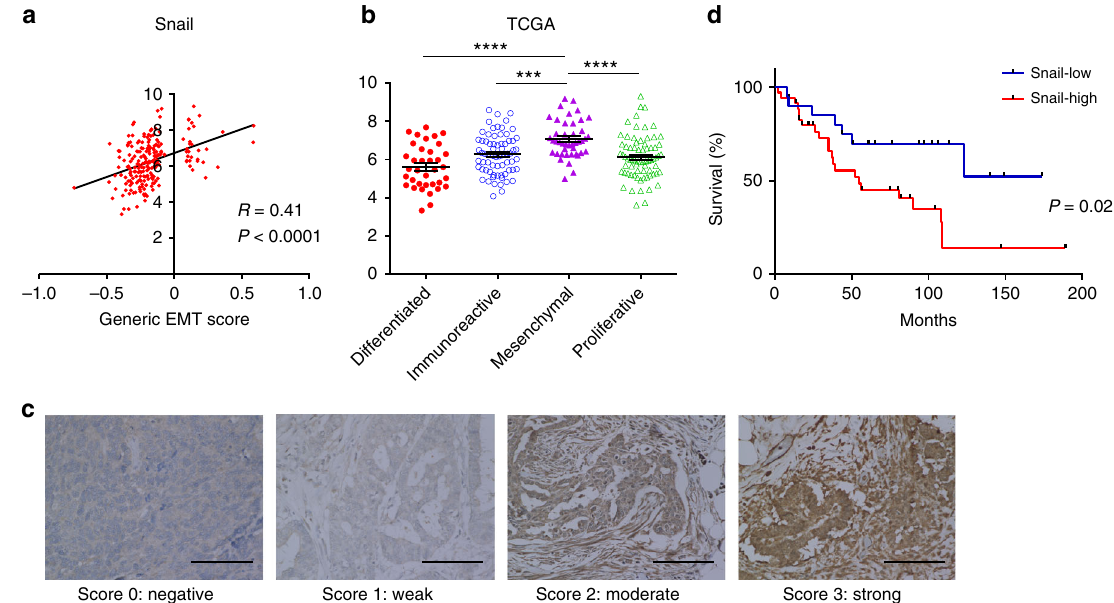
Fig. 1 Snail expression is related to epithelial-to-mesenchymal transition and poor prognosis in ovarian cancer. a Correlation between generic epithelial-to- mesenchymal transition (EMT) scores for 266 high-grade serous ovarian cancer (HGSOC) samples from TCGA dataset 1 and Snail expression. The EMT signature was acquired from a previous report by Tan et al. 3 . Generic EMT scores were calculated following the method of single-sample Gene Set Enrichment Analysis (ssGSEA). The correlation coef fi cient ( R ) and P -value were based on Pearson ’ s product-moment correlation analysis; R = 0.41 P < 0.0001. b Snail expression in HGSOC samples representing four subtypes from the TCGA datasets; *** P < 0.001 and **** P < 0.0001, mesenchymal vs. the other three subtypes based on one-way ANOVA with Tukey ’ s multiple comparisons test. Bars: mean and SEM. c Classi fi cation of HGSOC as determined by the intensity of nuclear Snail immunostaining. Cases with scores of 0/1 were assigned to the Snail-low group, whereas those with scores of 2/3 were assigned to the Snail-high group to be used in survival analysis. Scale bars, 100 μ m. d Overall survival curves for patients with HGSOC in Kyoto University Hospital ( n = 56; 48 stage III cases and 8 stage IV cases), based on Snail staining of disseminated tumors in the omentum. P = 0.021 by log-rank